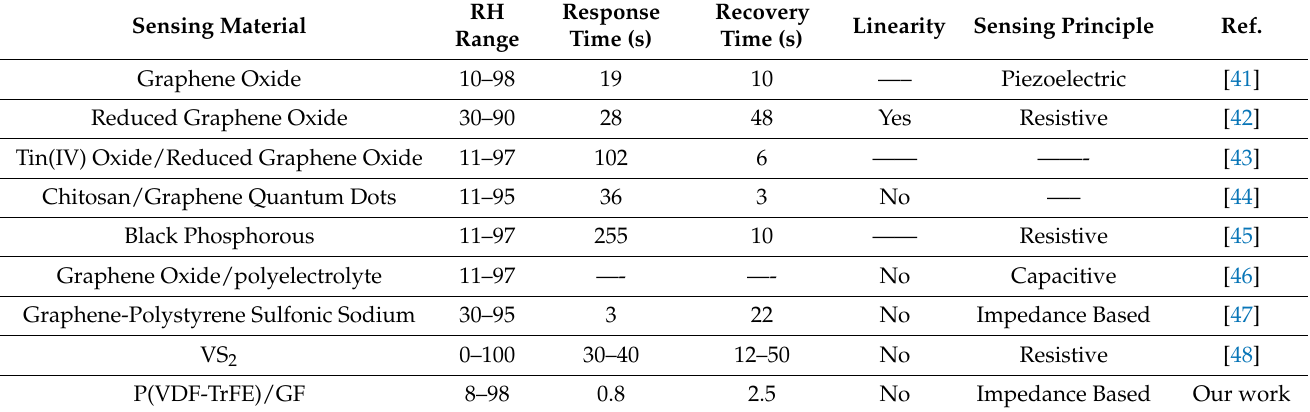
Table 1. A comparison table of the proposed sensor with other previously reported humidity